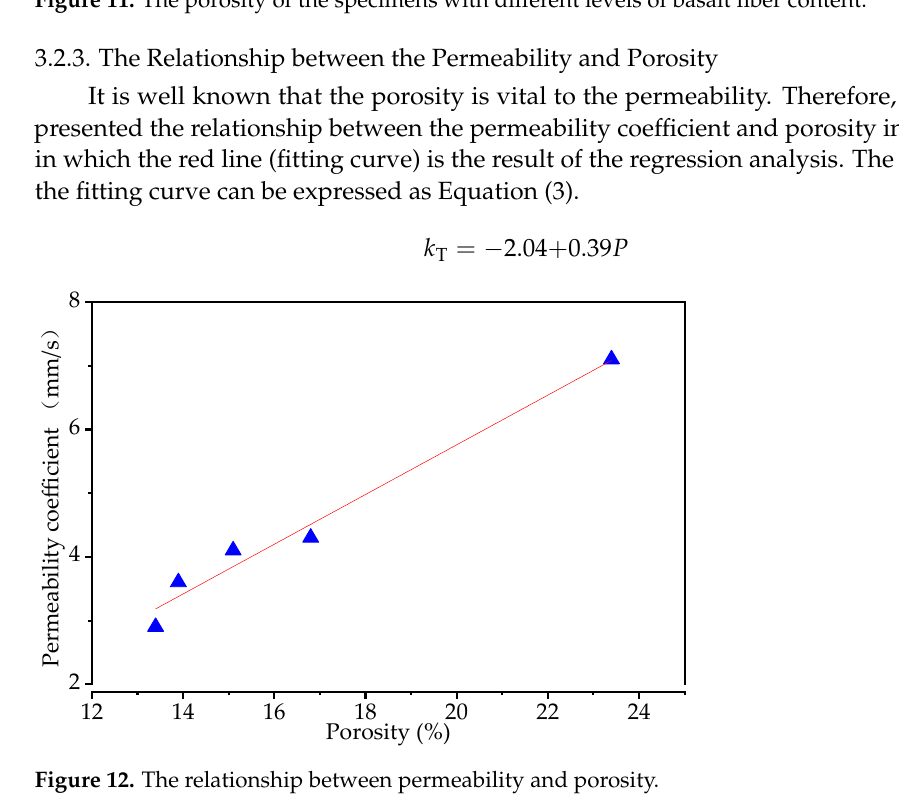
Figure 11. The porosity of the specimens with different levels of basalt fiber content.